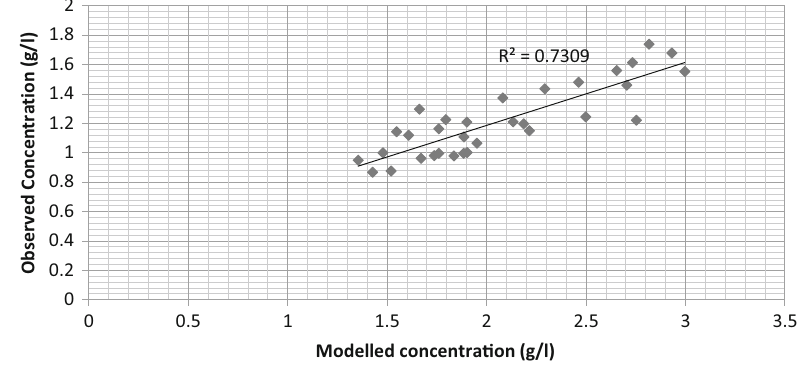
Fig. 5 The regression between nitrogen oxides concentration in modelling and field measurement - winter